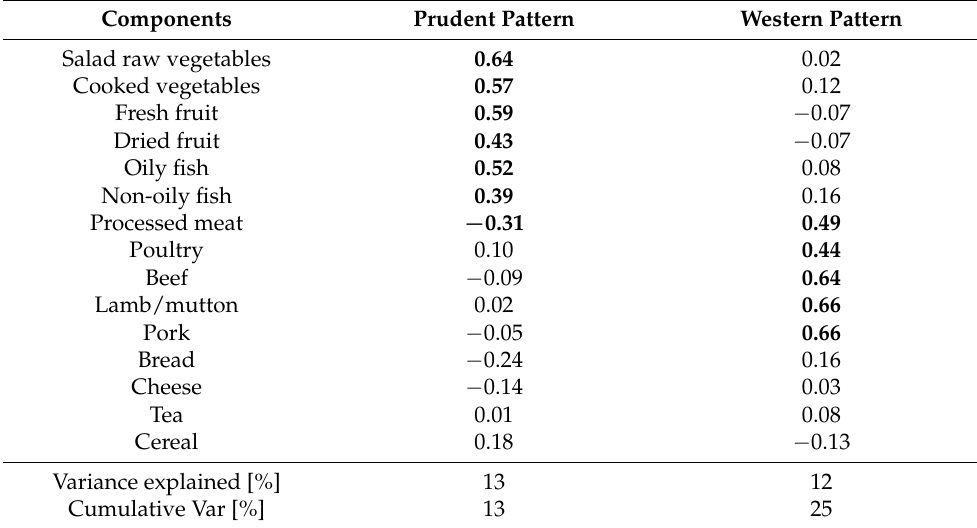
Table 2. Factor loadings for dietary patterns in the UK